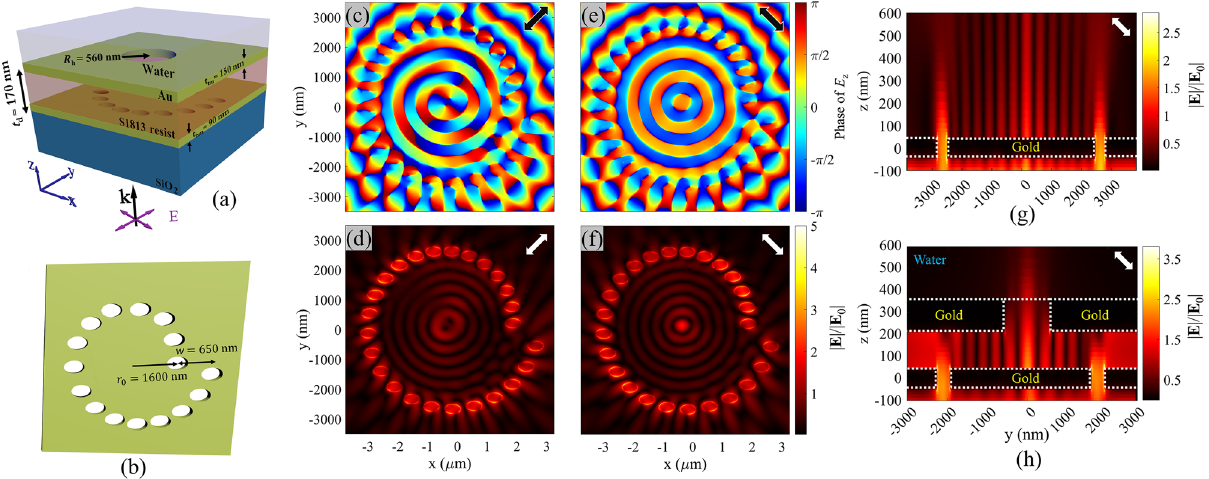
Figure 5. ( a ) Three-dimensional scheme of MIM structure (design II). ( b ) The schematic diagram of the array of elliptical holes with geometrical charge m = + 1 embedded in the bottom gold layer in the design. In the absence of MIM configuration, and for λ 0 = 1064 nm: ( c , d ) Phase distribution of E z and the normalized electric field distribution, for θ = 45°, and ( e , f ) Phase distribution of E z and the normalized electric field distribution, for θ = − 45°. Cross ( y – z plane) views of the normalized field distribution for linear polarization with θ = − 45°, ( g ) in the absence, and ( h ) presence of MIM structure. Black and white arrows in parts ( c – h ) show θ orientation. Dashed white lines show boundaries of the gold layers in parts ( g , h